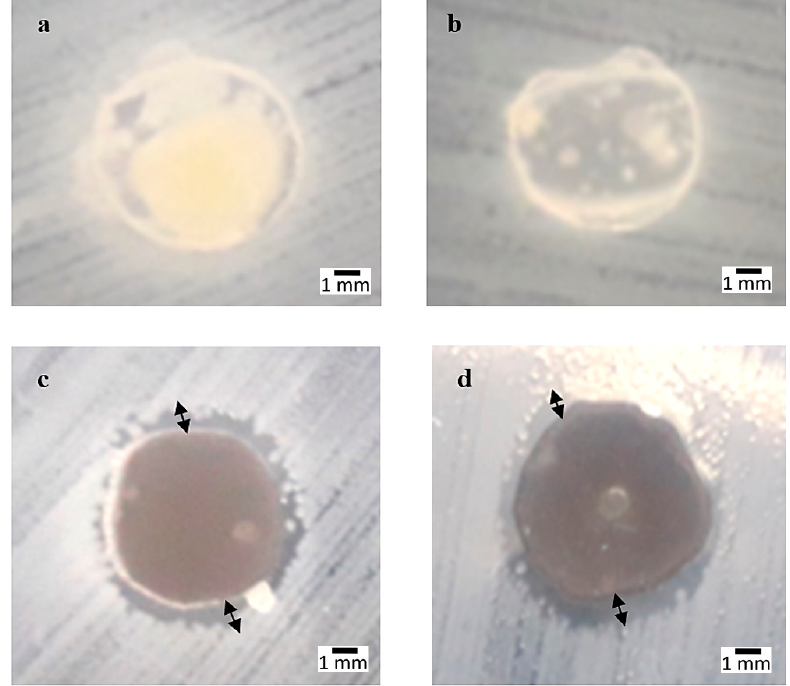
Figure 3. Salmonella cholerasuis strain: ( a ) Sugar palm starch (SPS), ( b ) 0 wt%, ( c ) 3 wt%, ( d ) 4 wt% compositions. Increasing the weight composition of AgNPs would produce an effective result, but the solution became dense and more agglomerated, causing an increase in the size of nanoparticles and level of toxicity. Moreover, the size and shape of the AgNPs played an important role in the enhancement of antimicrobial activity [66]. It can be concluded that, higher compositions gave smaller nanoparticles size and more effective in deactivation of active pathogen for reducing bacterial attachments. Overall results showed 3 wt% of AgNPs was the best composition and recommended to be used for antibacterial film. This was due to higher measurements of inhibition area with smaller nanoparticles size that appeared to have the same effectiveness as 4 wt% with less toxicity effects.